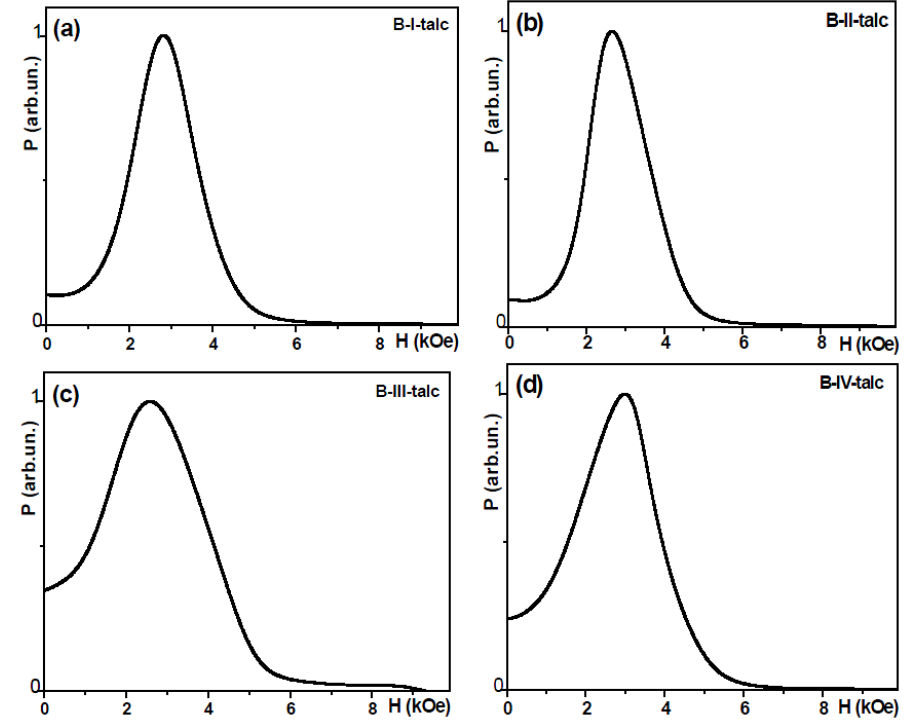
Figure 6. Microwave resonant absorption as a function of the external magnetic field for Series B samples, f = 9.5